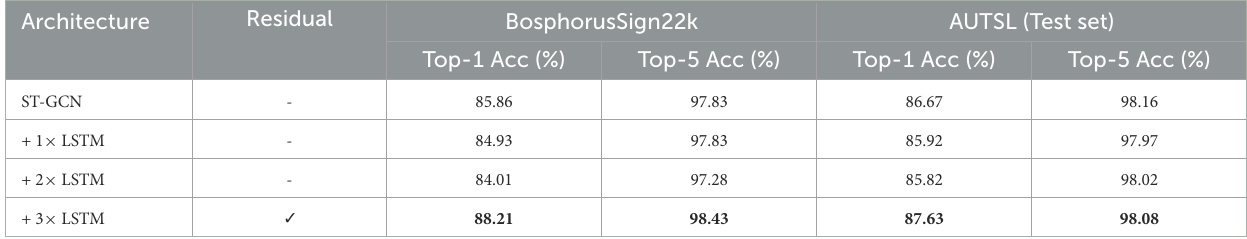
TABLE 1 Recognition performance on BosphorusSign22k and AUTSL datasets using hybrid ST-GCN and LSTM